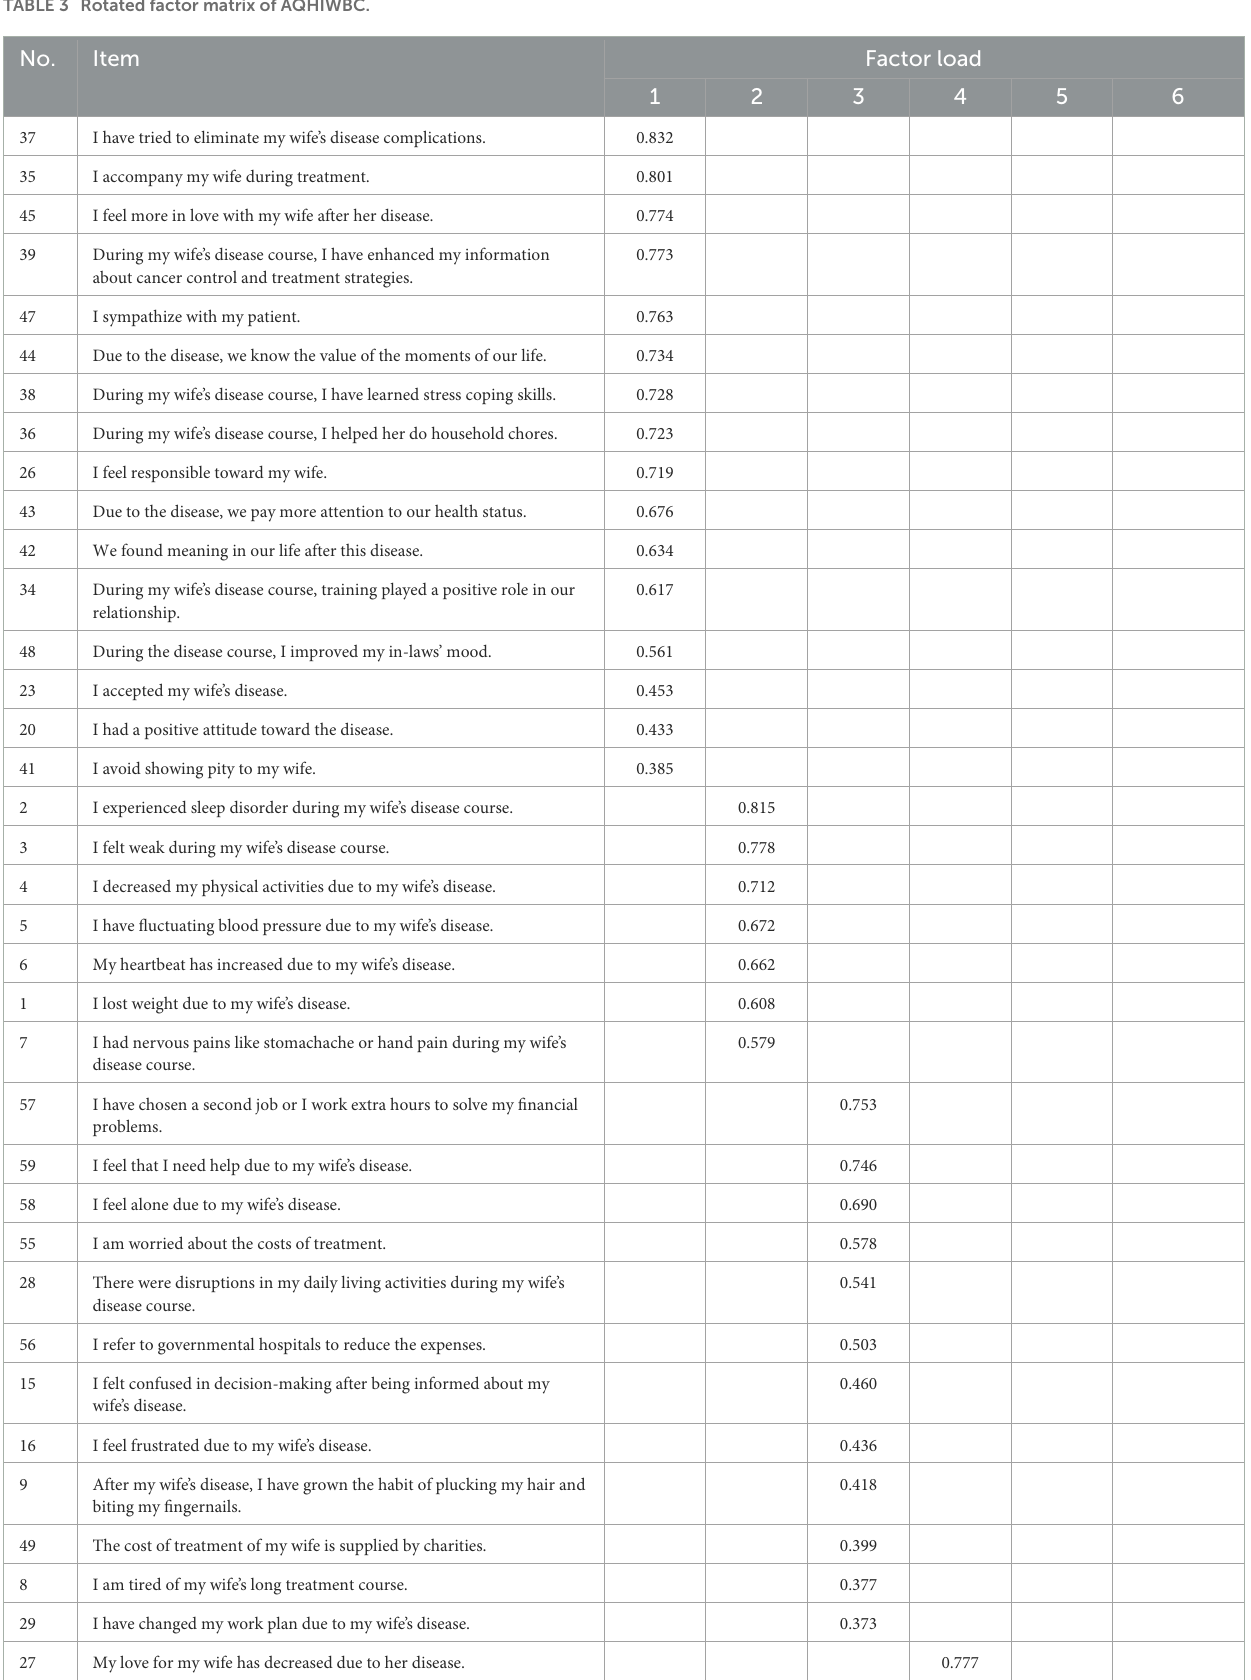
TABLE 3 Rotated factor matrix of